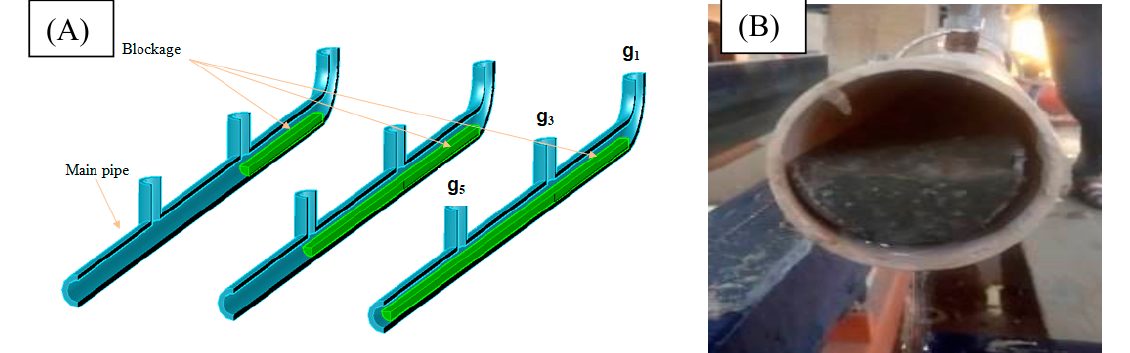
Figure 14. Relationship between WO and LO for different relative blockage heights at Q = 1.20 L/sec.